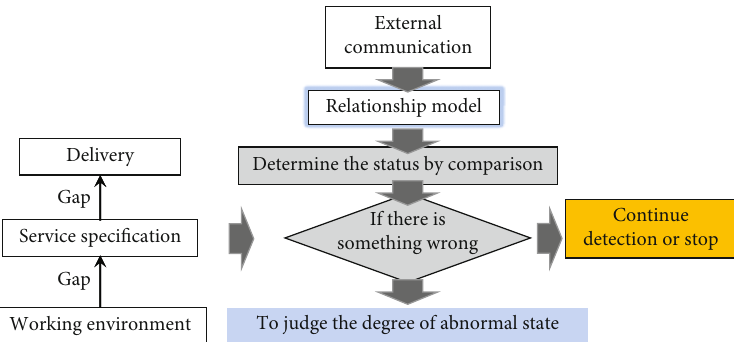
Figure 1: Research model of working